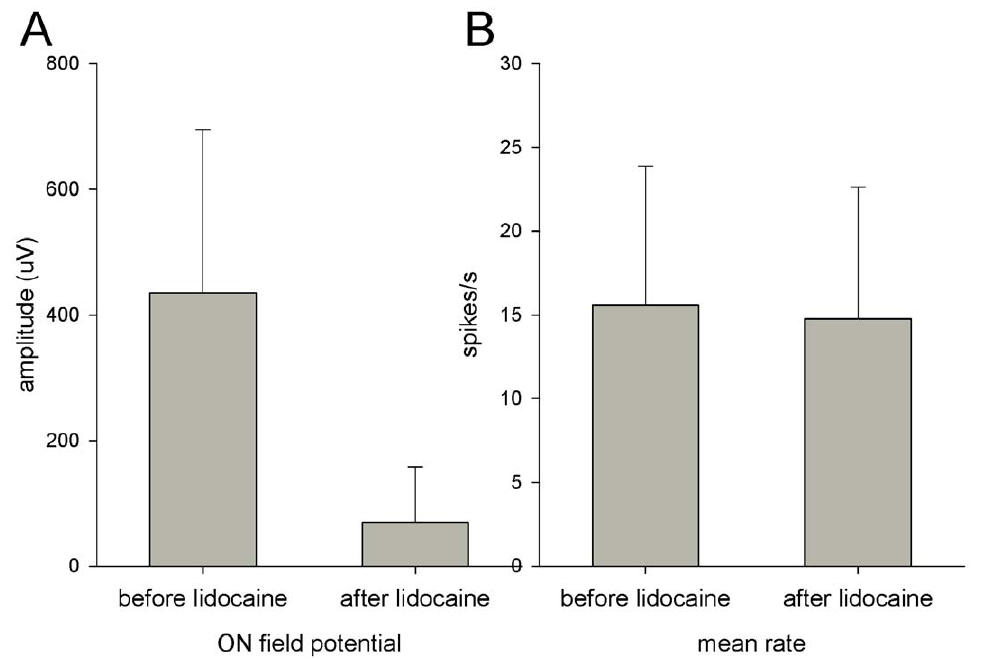
Figure 2. The effects of olfactory nerve block on mean rate. The mean change in the amplitude of the ON-evoked field potential (A) caused by lidocaine application is compared to the mean change in the rate of spontaneous activity (B).